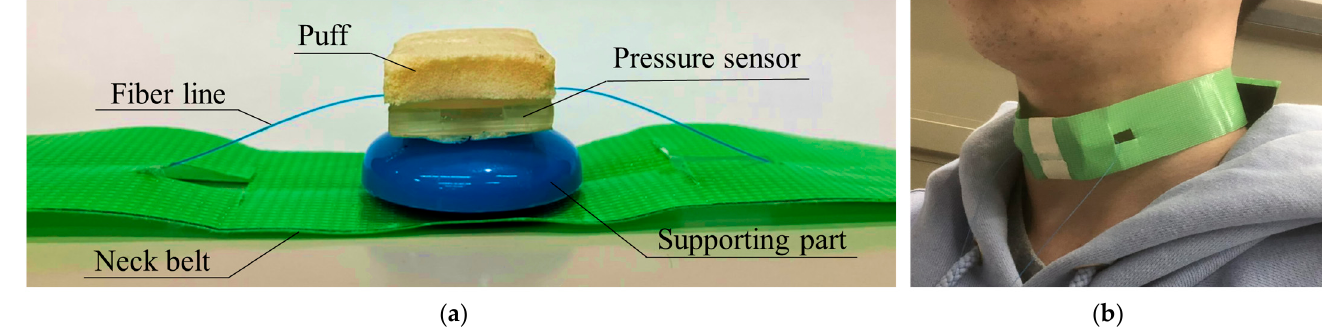
Figure 3. Wearable swallowing test device: ( a ) photograph of the wearable swallowing assessment device; ( b ) appearance when a user attaches the wearable swallowing assessment